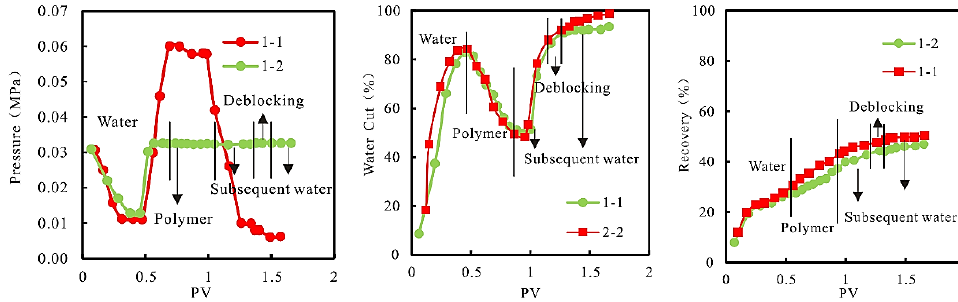
Figure 4. Relationship between injection pressure, water cut, and recovery and PV.